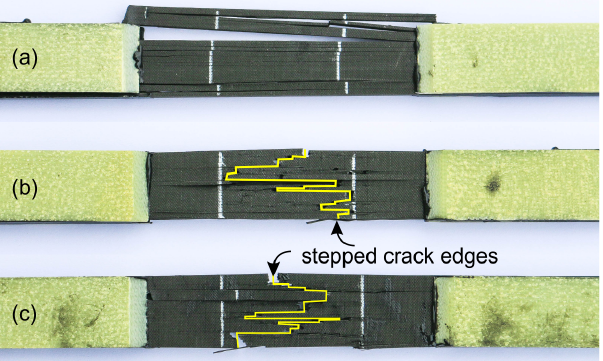
Figure 7. Tensile test specimens after testing ( a ) unpinned; ( b ) pinned with unnotched z-pins; ( c ) pinned with notched z-pins (notch depth 20 µ m, notch distance 100 µ